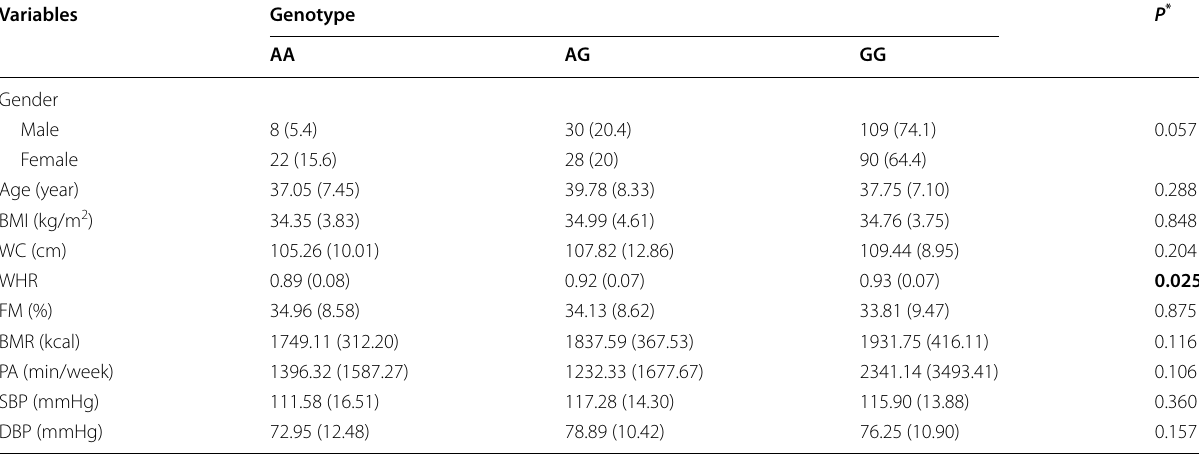
Table 1 General characteristics of study subjects based on CARTPT rs2239670 polymorphism